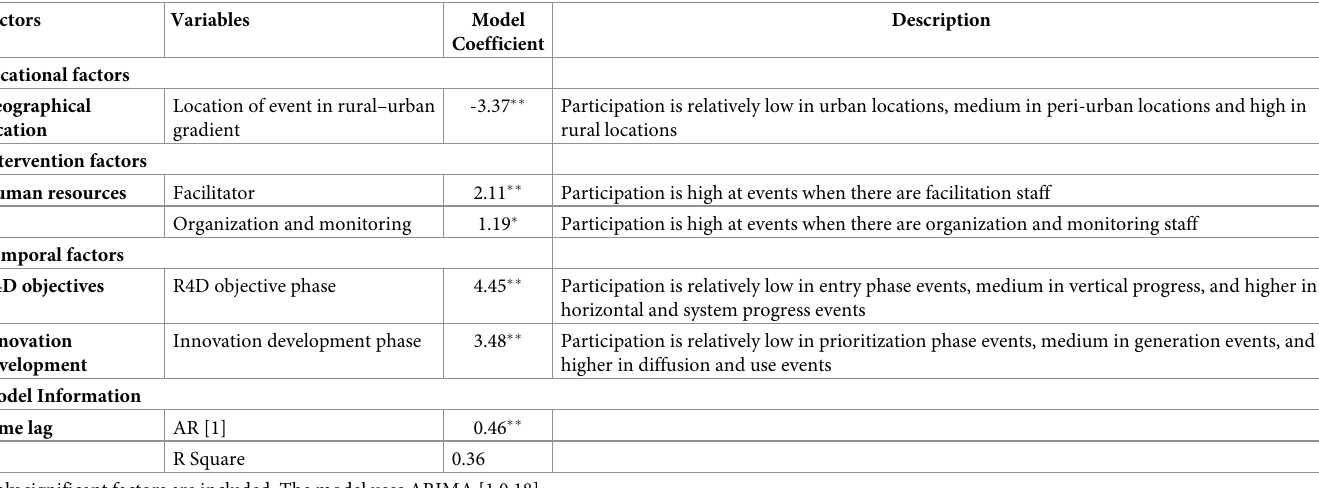
Table 5. Linear regression results for participation. Numbers in the third column represent the coefficients for statistically significant factors of participation with 0.01 [ �� ] and 0.05 [ � ] confidence